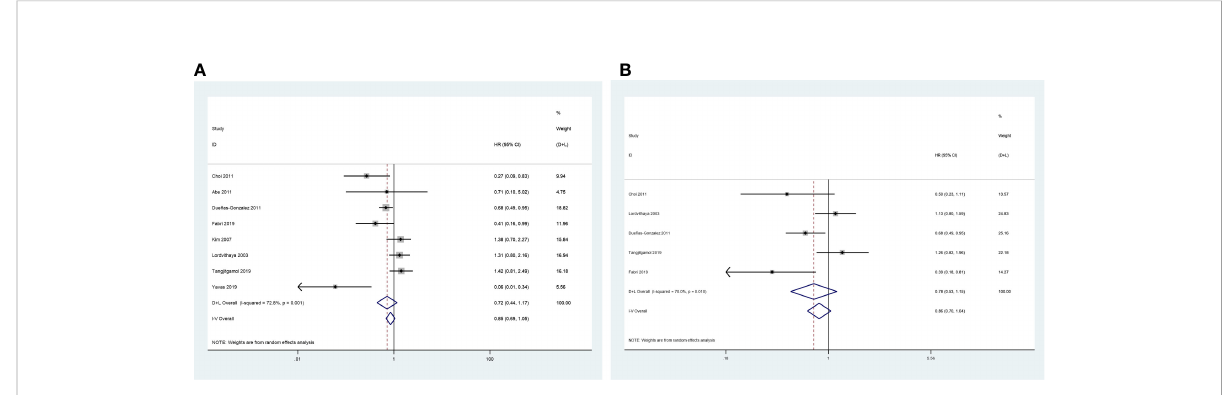
FIGURE 5 Forest plot of the survival rates. (A) 3-year rates of OS; (B) 3-year rates of